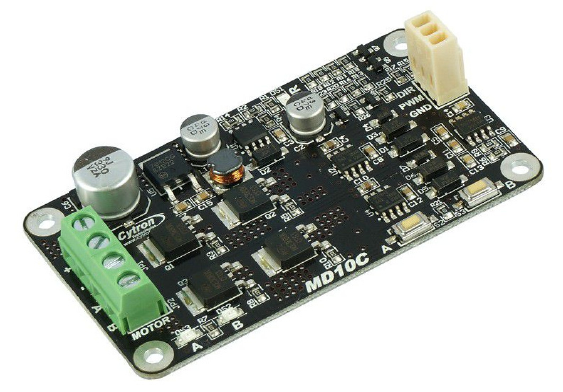
Figure 3. MD10C driver